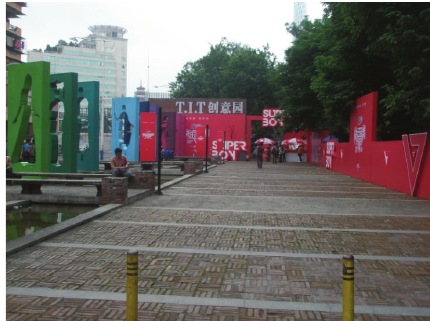
Figure 10: Cultural square of T.I.T Park.